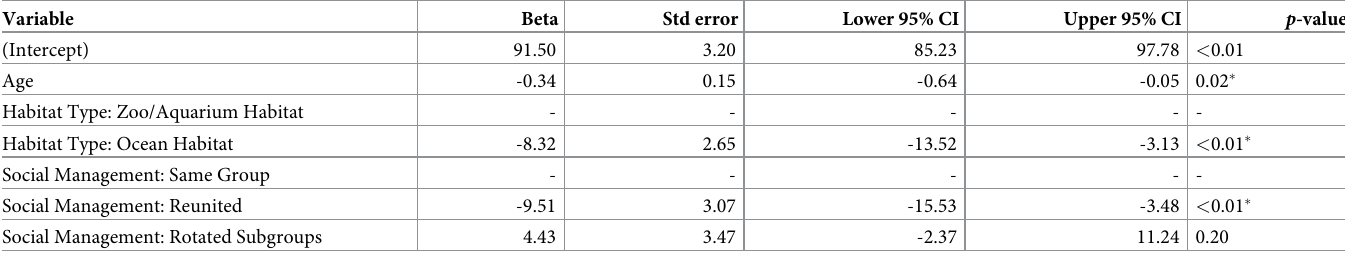
Table 7. Results for the full multivariate model examining top third habitat use.